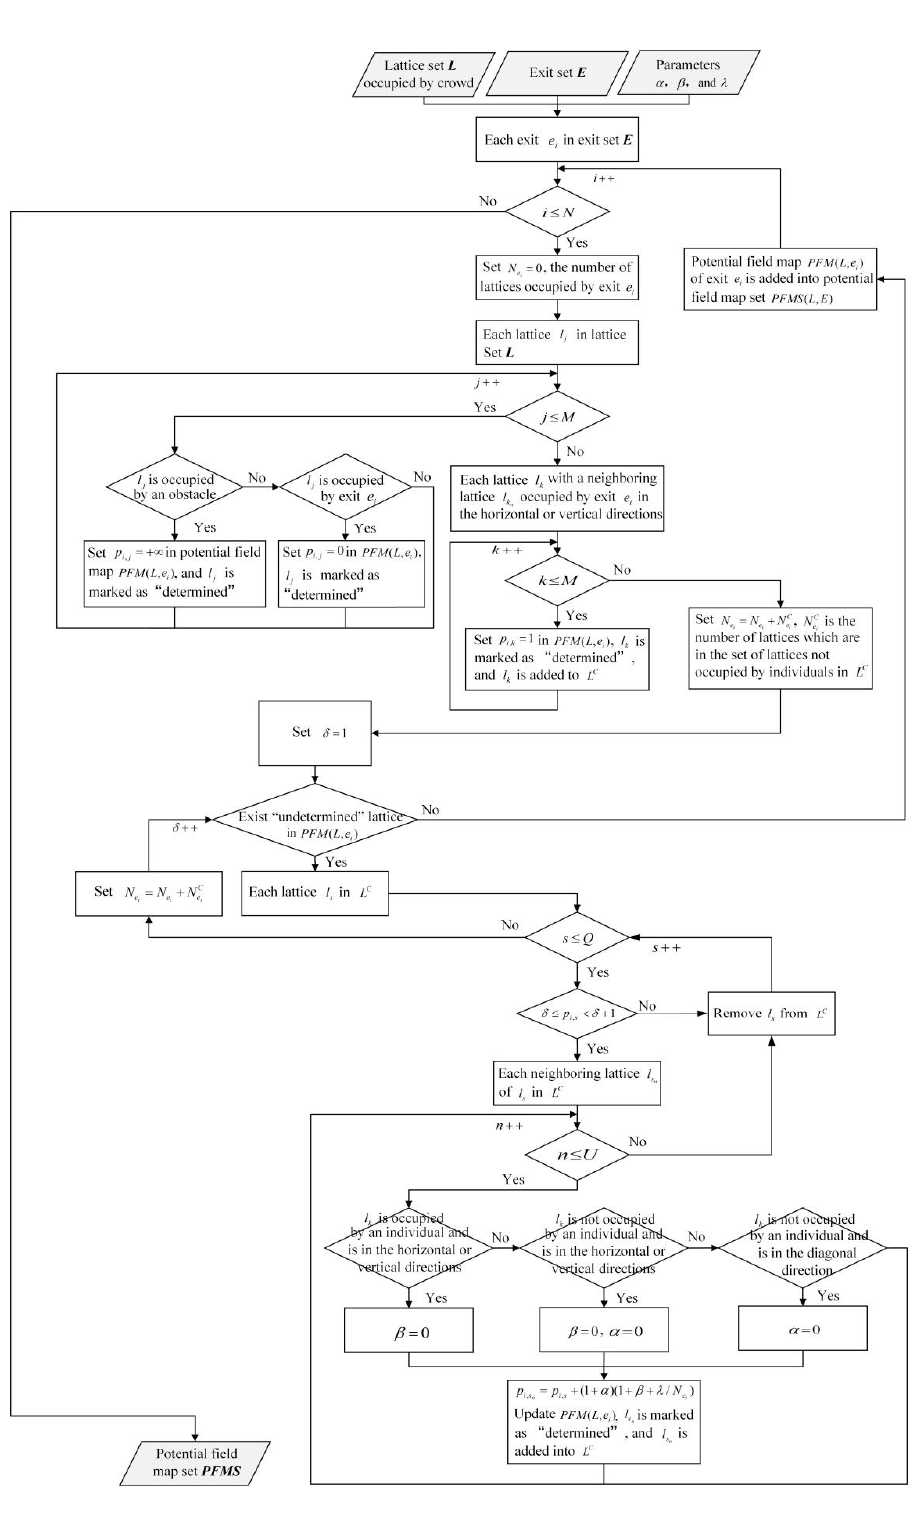
Figure A1. Flowchart of potential field map calculation.